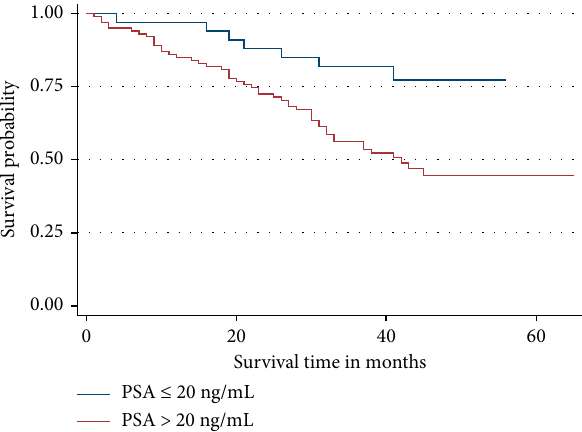
Figure 5: Overall survival by Gleason score. Patients with poorly differentiated disease were more likely to die than the ones with differentiated